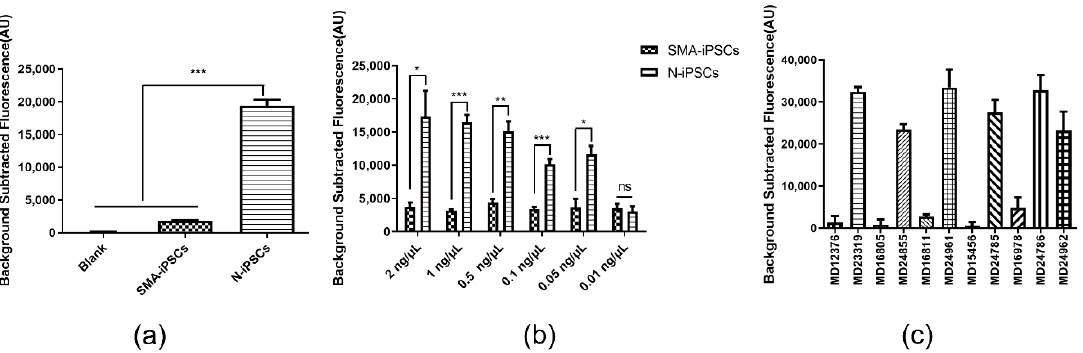
Figure 3. Detection Performance of Secondary PCR and SMA-Cas14a1 Assay. ( a ) Fluorescence signals of DNA from N-iPSCs and SMA-iPSCs amplified using secondary PCR. ( b ) Minimum detectable concentration of gDNA of SMA-Cas14a1 assay combined with secondary PCR. Data are means ± SEM; *** p < 0.005, ** p < 0.01, * p < 0.05; ns, p > 0.05. ( c ) Validation of SMA-Cas14a1 assay combined with secondary PCR by using gDNA from clinical samples. Data are means ± SEM.